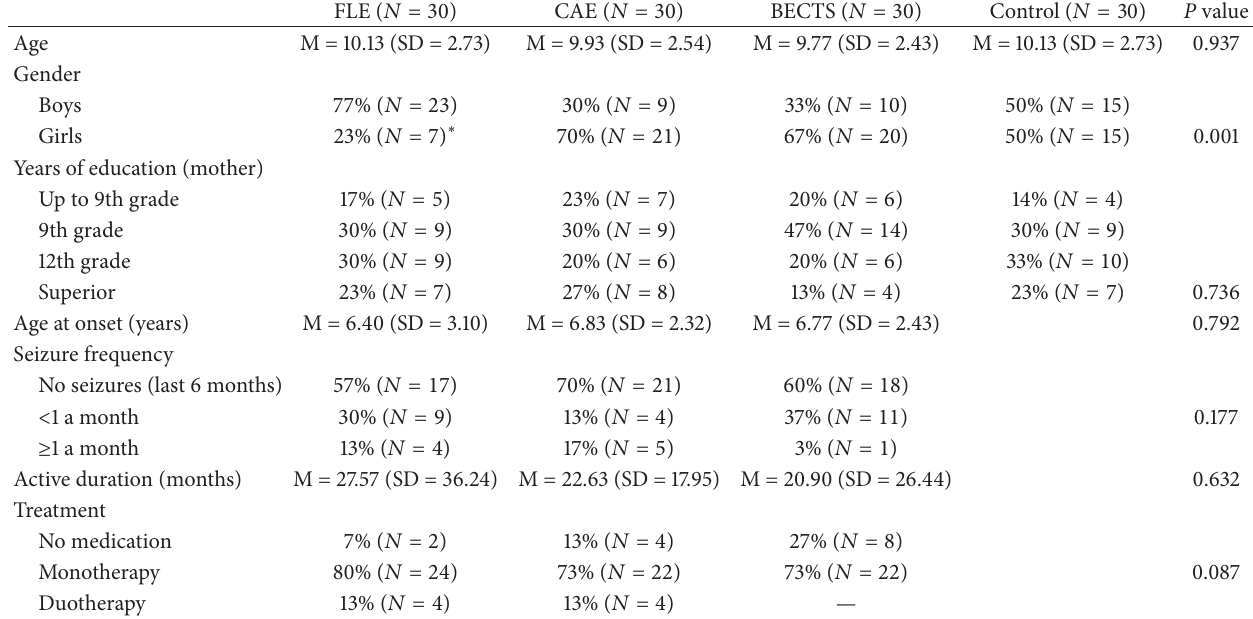
Table 1: Demographic and neurological features.